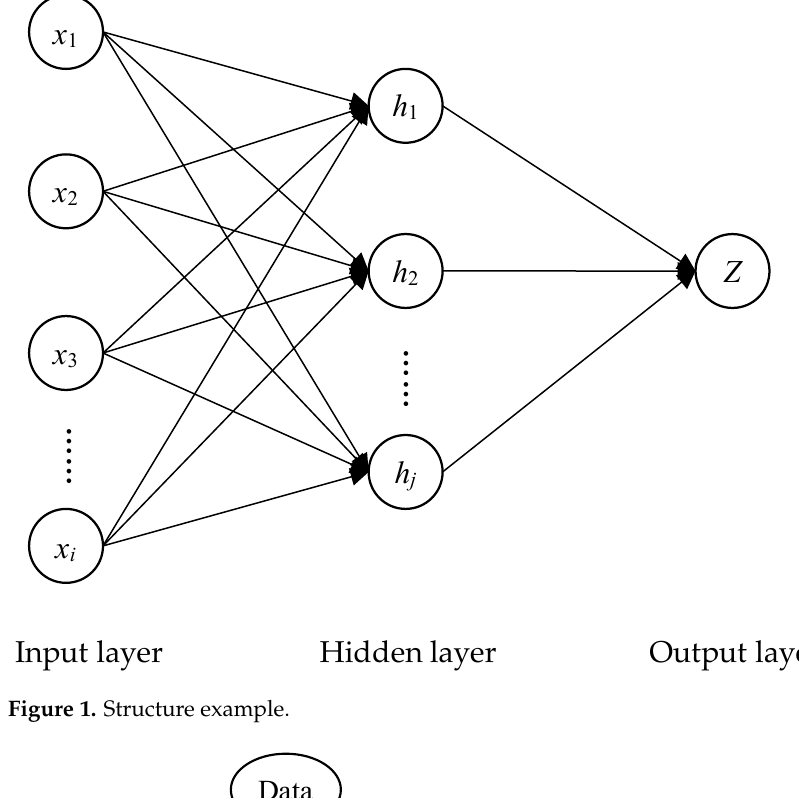
Figure 1. Structure example.